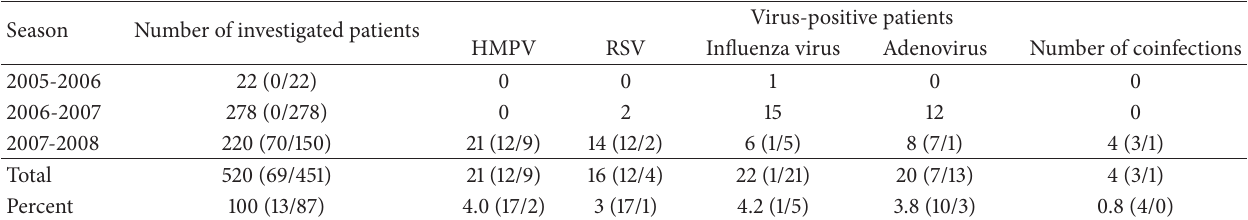
Table 3: Detection of respiratory viruses in patients with LRTI